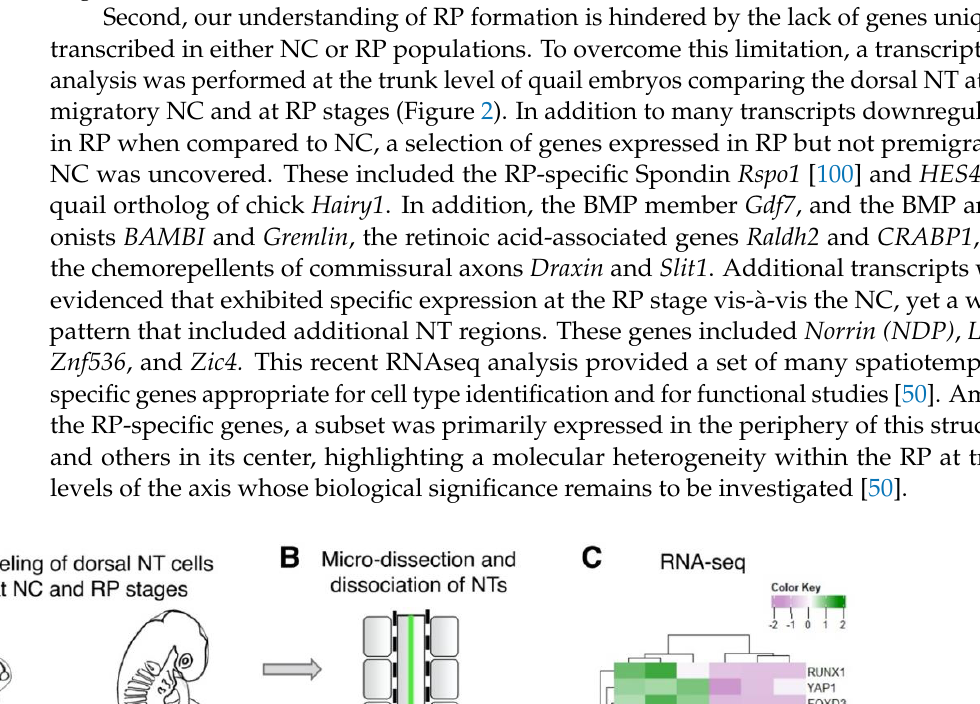
Figure 3. Differential properties of the RP at various axial levels. The hindbrain RP (purple) forms as an enlarged sheet of squamous epithelial cells bordered by the rhombic lip epithelium. The lat- eral domains of the hindbrain RP generate choroid plexus cells (hCP). The RP at spinal cord levels (green) is initially composed of pseudostratified epithelial cells, which are later transformed into